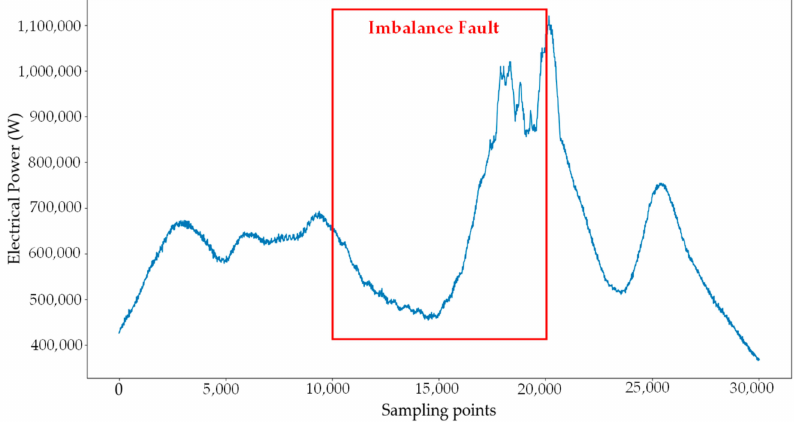
Figure 6. Imbalance fault occurs from the 10,000th to 20,000th sampling